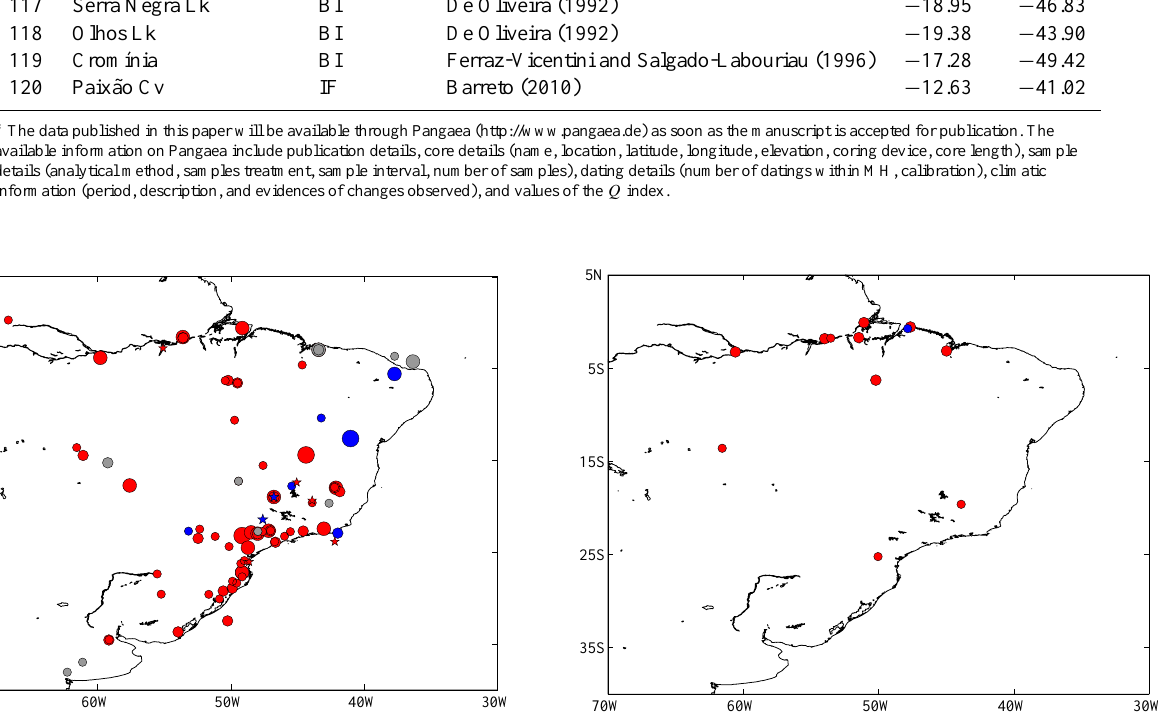
Fig. 5. MH lake level palaeodata in eastern South America. Sym- bol colours: red, lower than present; and blue, higher than present. Symbol size refers to palaeodata Q -index (a chronological reliabil- ity index; see text for more information) values; larger symbols in- dicate higher Q -index values. Vertical axis refers to latitude values, and horizontal axis refers to longitude